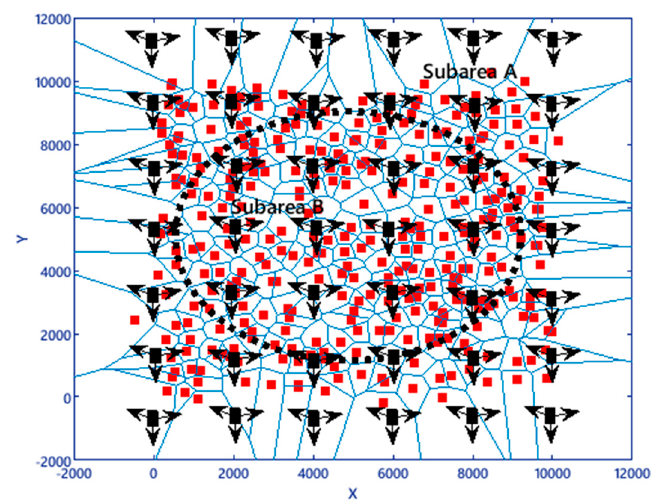
Figure 7. 5G planning at 38 GHz with overlay deployment architecture. UMa are represented by black squares, whereas UM1 are represented by red squares and BSs sector is represented by an arrow.